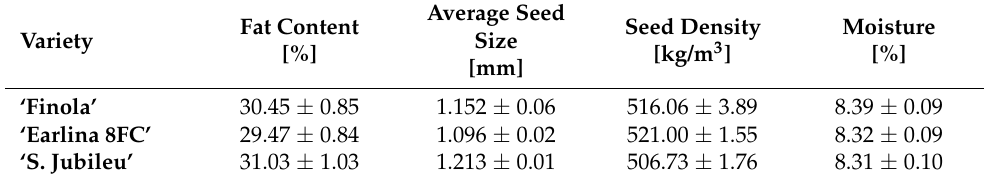
Table 7. Parameters of hemp